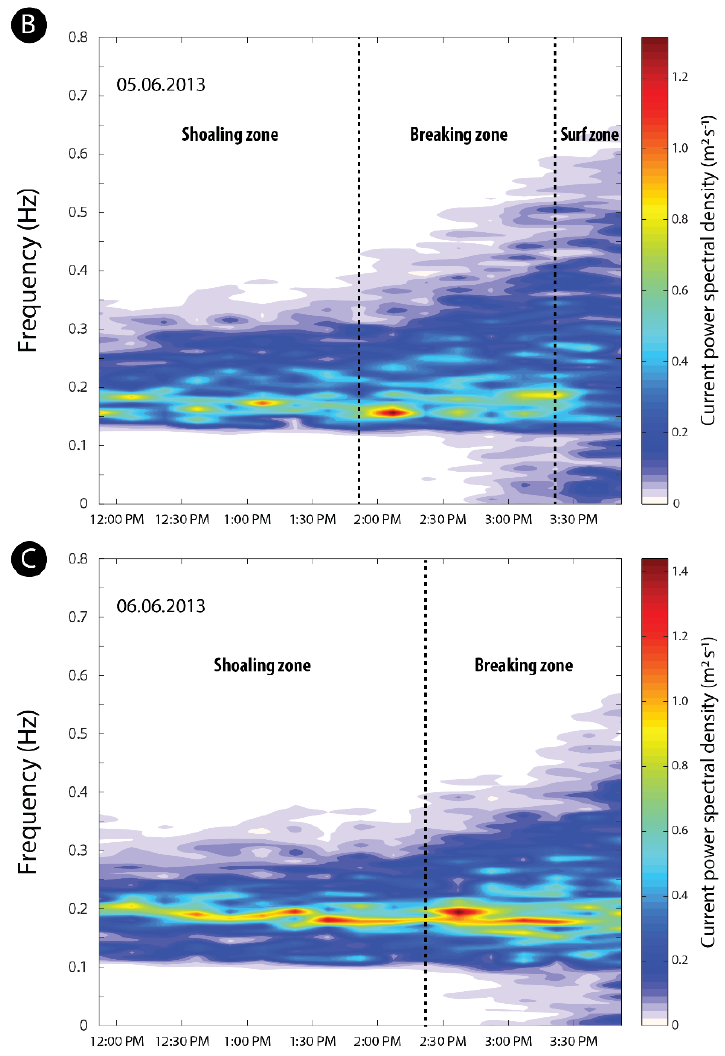
Figure 11. Temporal variations in frequency and power spectral density of cross-shore currents over bar B3 (see Figure 2D for location) under non-breaking and breaking wave processes as water depth decreased during falling tide during moderate energy conditions (offshore H s ≈ 1.2 m) on ( A ) 4 June (high tide at 10:30 AM and low tide at 05:30 PM) and ( B ) 5 June 2013 (high tide at 11:30 AM and low tide at 06:30 PM), and during higher energy conditions (offshore H s ≈ 1.4–1.5 m) on ( C ) 6 June 2013 (high tide at 12:15 AM and low tide at 19:15